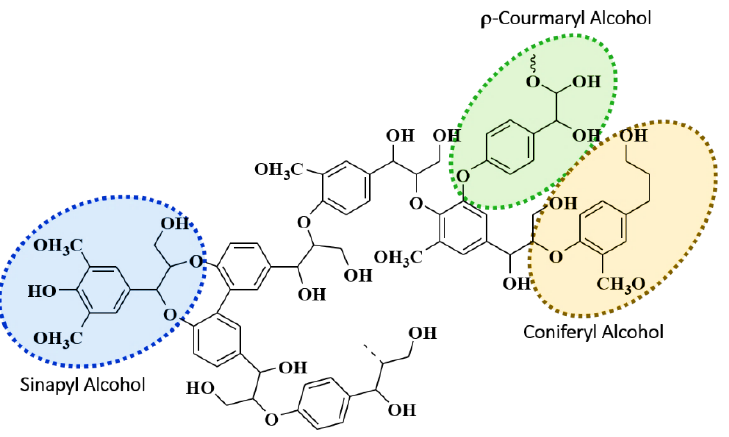
Figure 1. Chemical structure representation of lignin showing its major aromatic alcohol units.